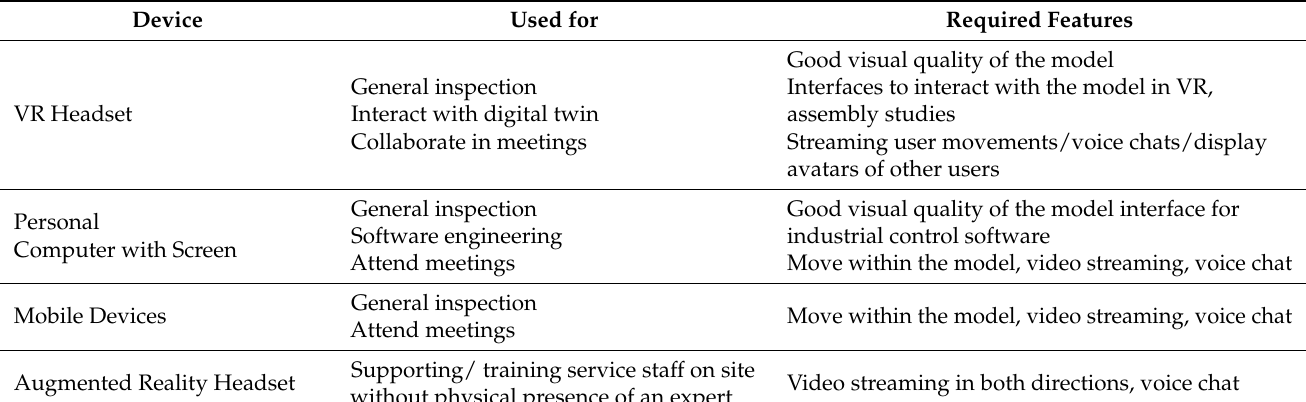
Table 1. Overview of hardware and features [5] (p.